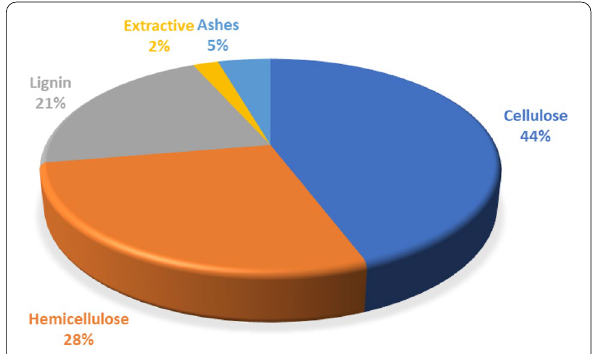
Fig. 2 Typical chemical composition of SCB (Karp et al.